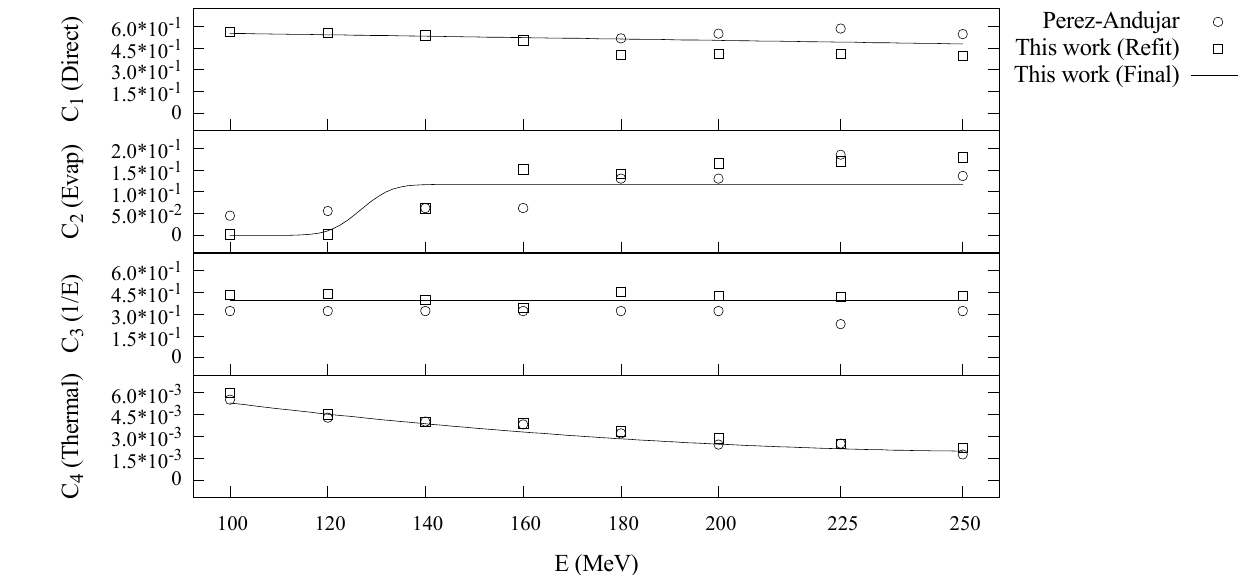
Figure 9. Plot of 𝐶 values for each neutron energy regime versus proton beam energy. 𝑖 Points represent 𝐶 values from Perez-Andujar et al. [14] (circles) and from a refitting of that 𝑖 model using the improved fitting methods (squares). The solid curves represent the parameterized 𝐶 (𝐸) models used in the final version. 𝑖